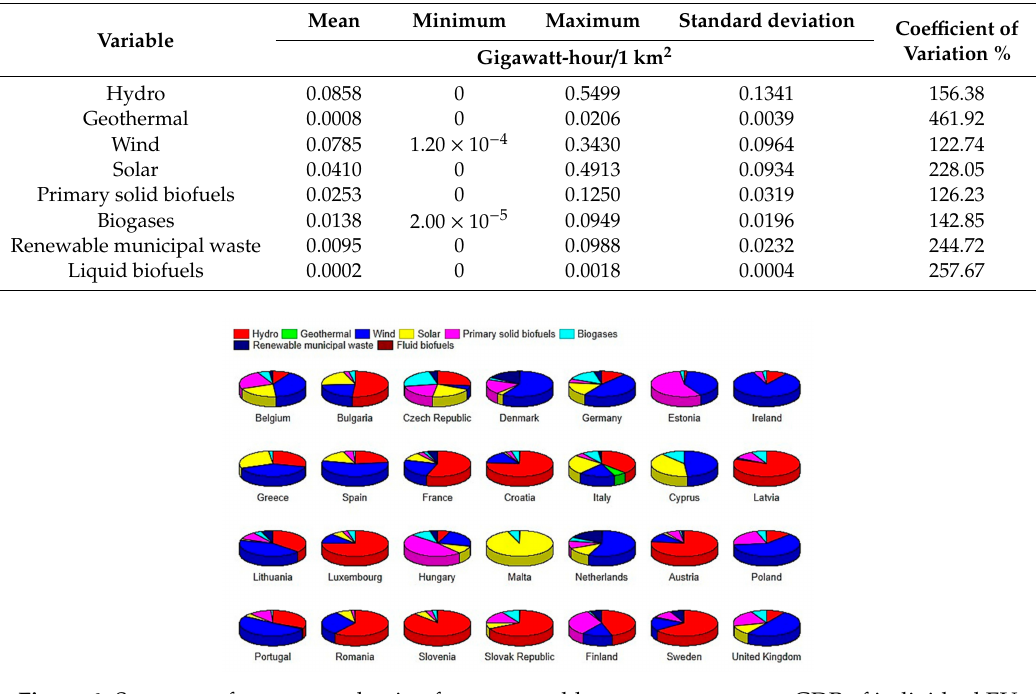
Figure 6. Structure of energy production from renewable energy sources per GDP of individual EU countries in 2017 (GDP according to nominal expenditure, in euro) (own study based on data from [37]).